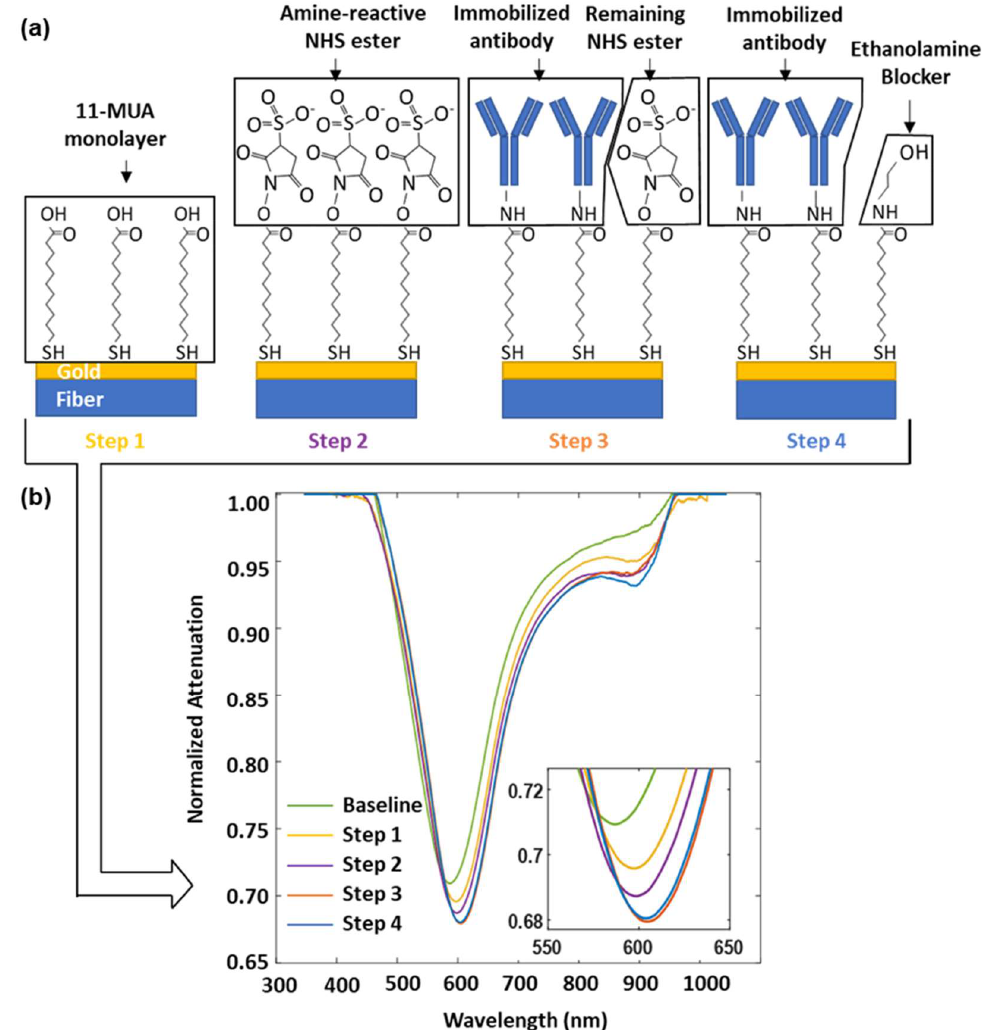
Figure 4. ( a ) Schematic of the surface functionalization of the plasmonic fiber probe for targeted MCF-7 cell sensing. Step 1: Form a self-assembling monolayer of 11-MUA on gold. Step 2: Activate the carboxyl groups on 11-MUA through the EDC/NHS reaction. Step 3: Immobilize the EpCAM antibody for the purposes of cell capture. Step 4: Block remaining active NHS esters. ( b ) SPR